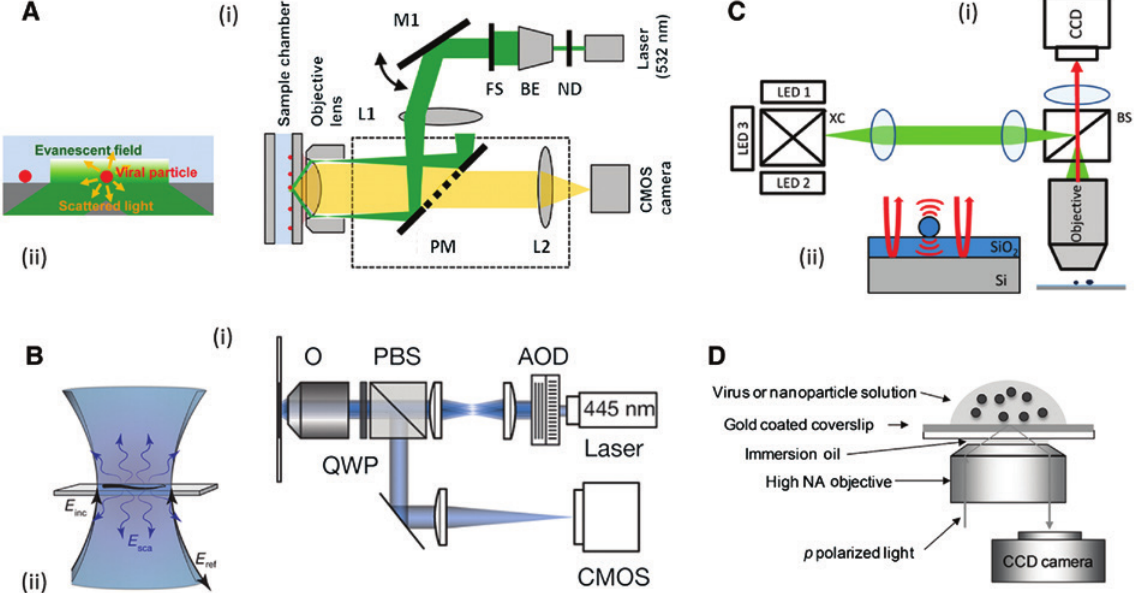
Figure 7: Label-free imaging methods for single bio-NP detection. (A) (i) Schematic representation of the experimental setup for TIRDFM: ND, neutral density filter; BE, beam expander; FS, field stop; M1, mirror; L1 lens; PM, perforated mirror; L2, objective lens. (ii) Pictorial representation of the detection event. Adapted from Ref. [100]. (B) (i) Schematic representation of the iSCAT optical setup: O, objective; QWP, quarter wave plate; PBS, polarizing beam splitter; AOD, acousto- optic deflector. (ii) Pictorial representation of the sample region, where the incident E , reflected by the substrate E , and scattered by the inc ref biomolecule E , are also shown. Adapted from Ref. [101]. (C) (i) Schematic representation of the optical setup for IRIS: XC, x-cube used to sca combine the beam of three different LED sources; BS, cube beam splitter. (ii) Pictorial representation of the layered substrate and of the optical paths leading to the interference signal. Adapted with permission from Ref. [102]. Copyright (2010) American Chemical Society. (D) Schematic representation of the SPRM experimental setup. Adapted from Ref.